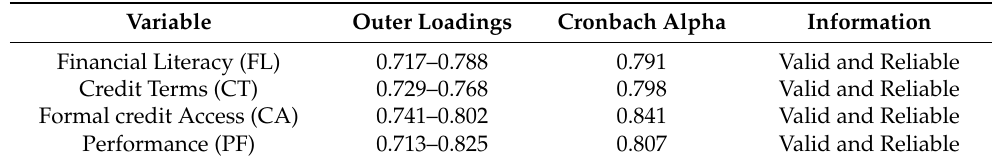
Table 3. Validity and Reliability Test Results.